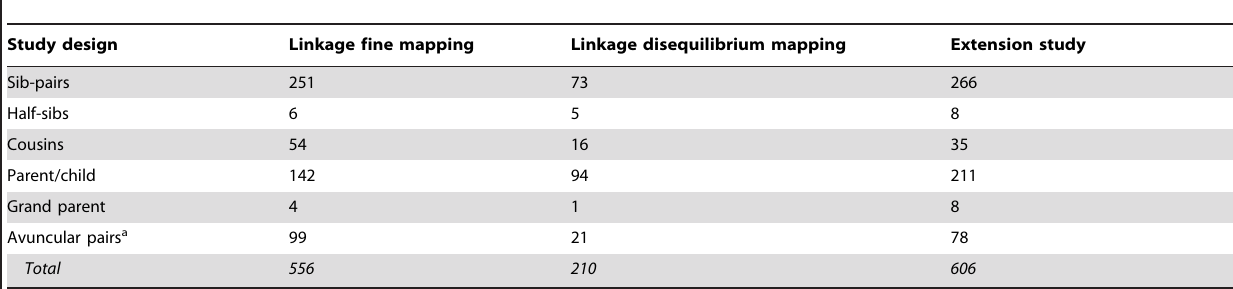
Table 1. Pairwise distributions among first and second degree relative pairs included in family-based study